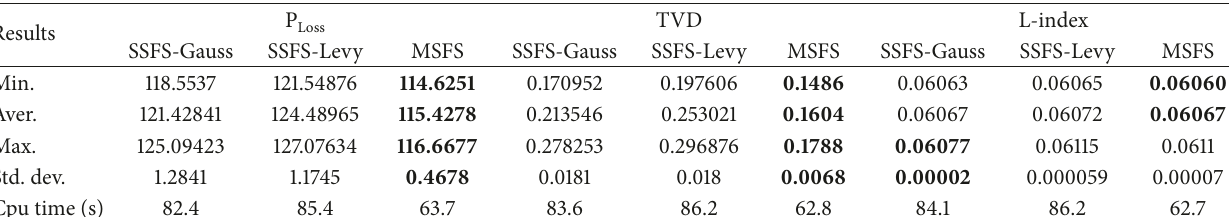
Table 4: Comparisons of result obtained by the proposed method, SSFS-Gauss and SSFS-Levy for three different objectives of IEEE 118-bus system.